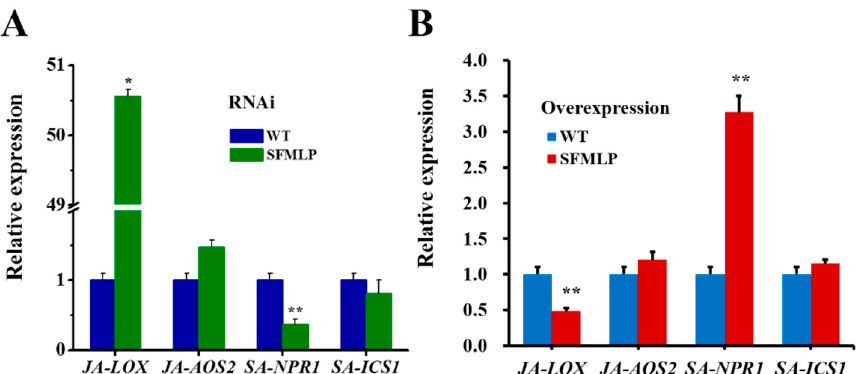
Figure 10. Relative expression levels of JA marker and SA marker genes in transgenic rice. ( A ) The expression levels of four genes in SFMLP - dsRNA -transgenic plants ( dsSFMLP ) and wild-type plants (WT); ( B ) the expression levels of four genes in SFMLP -overexpressing transgenic plants ( SFMLP ) and WT plants. * and ** indicate statistically significant differences ( t- test: p < 0.05 and p < 0.01). Bars, ± SEM.